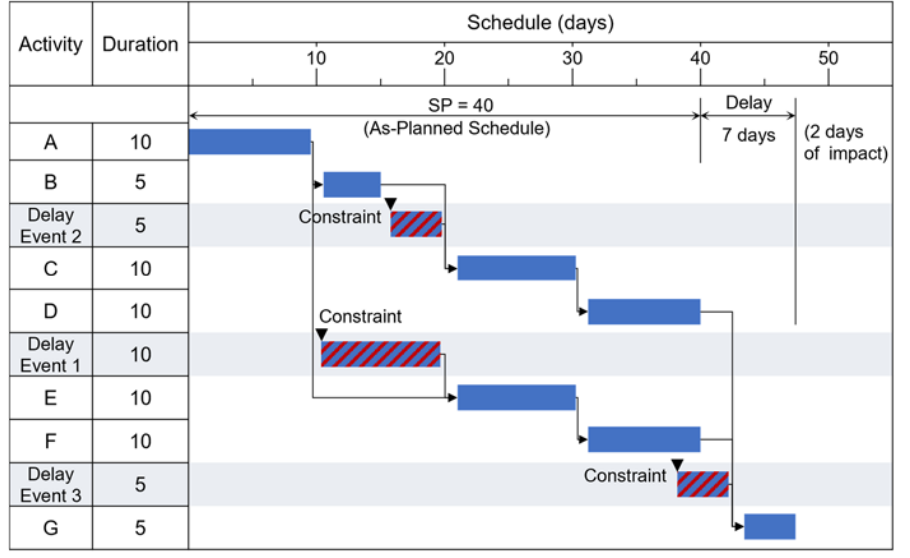
Figure 11. Impacted as ‐ planned using